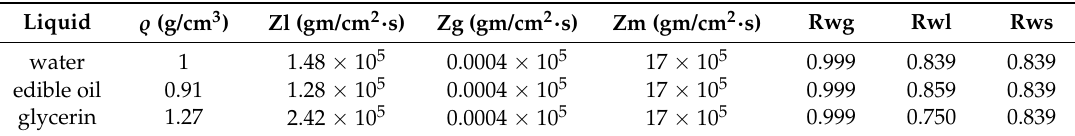
Table 1. Experimental parameters and initial values.